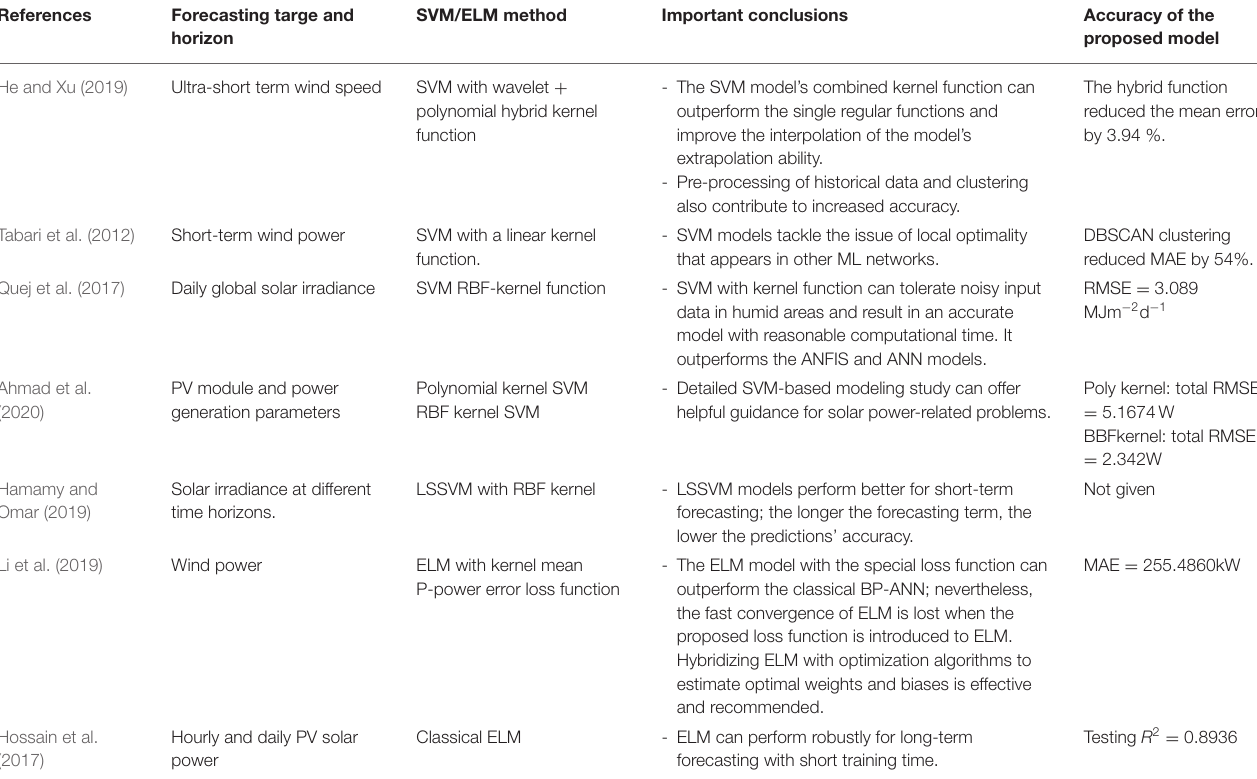
TABLE 3 | Summary of support vector machine (SVM) and extreme learning machine (ELM)